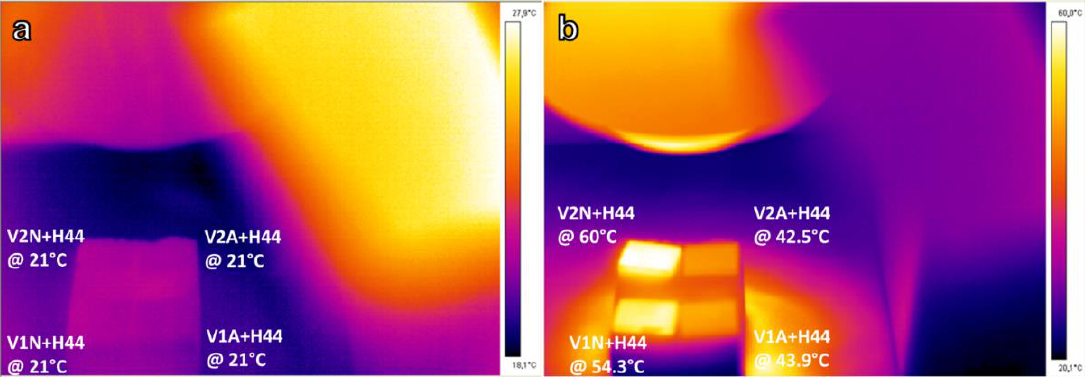
Figure 10. Infrared image of coated Ti blocks: ( a ) before, and ( b ) after 120 s IR irradiation.